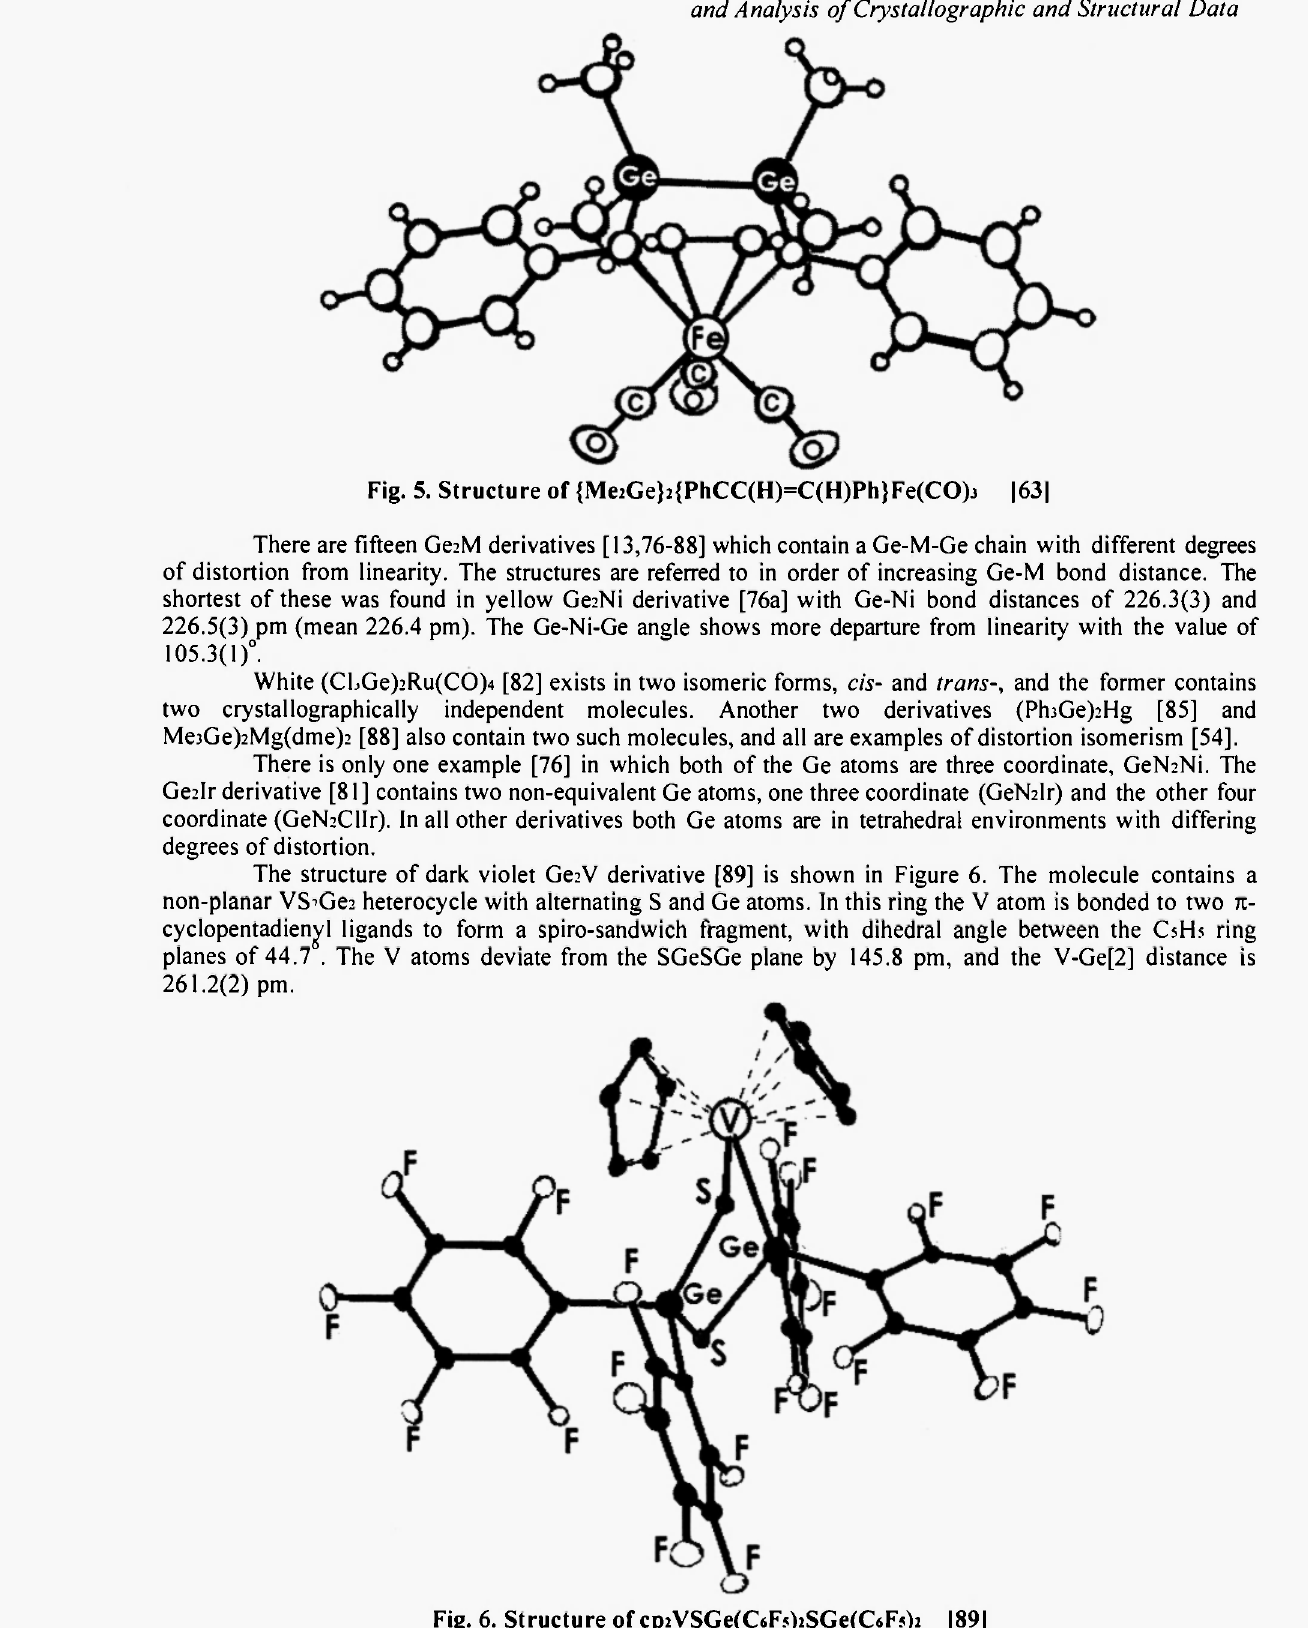
Fig. 6. Structure of